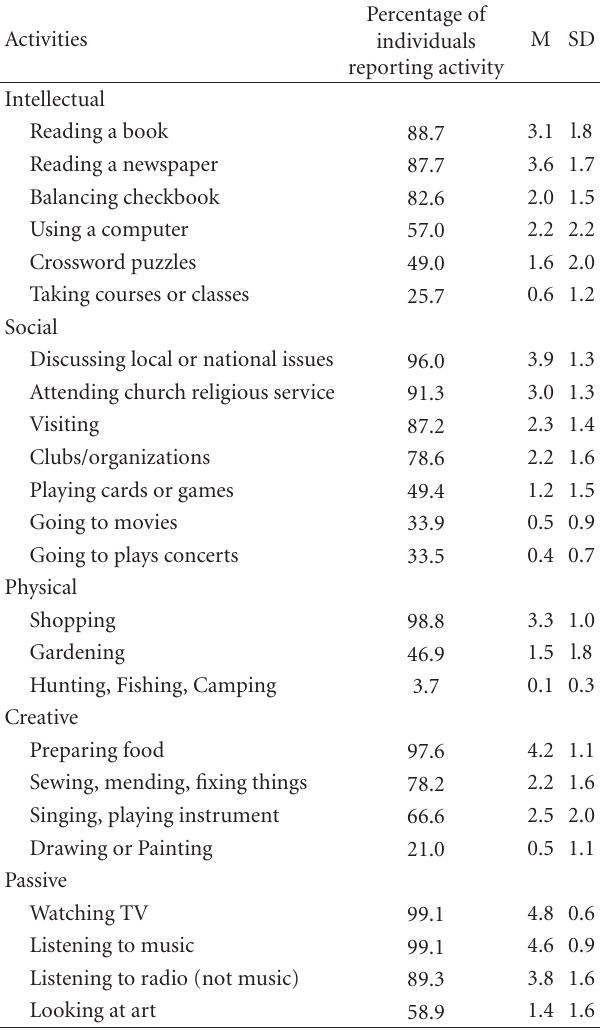
Table 2: Activity domains from the lifestyle activities